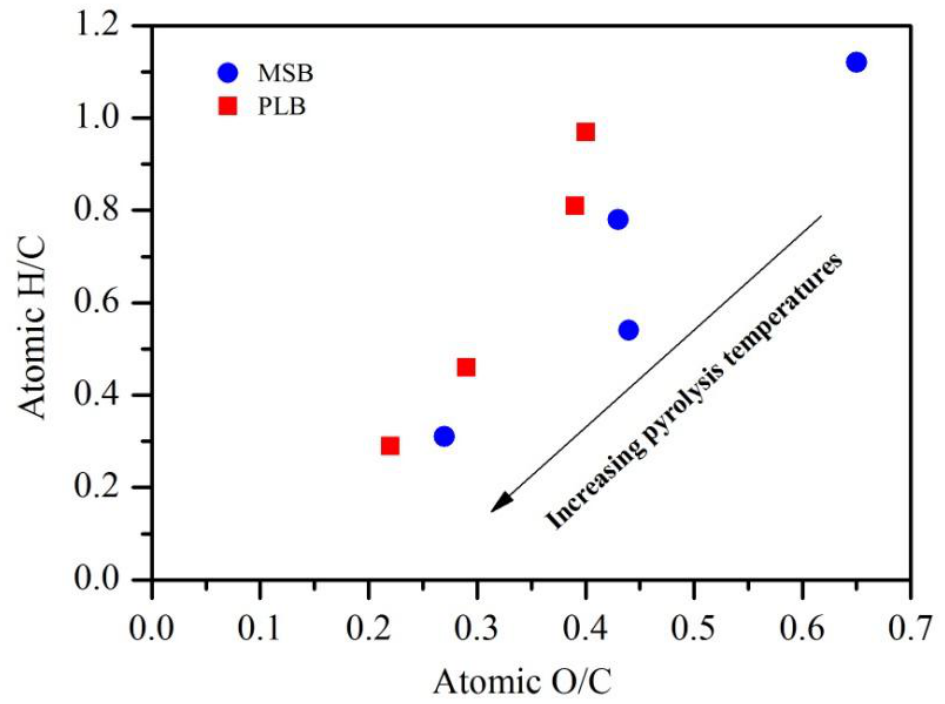
Figure 1. H/C and O/C atomic ratios with increasing pyrolysis